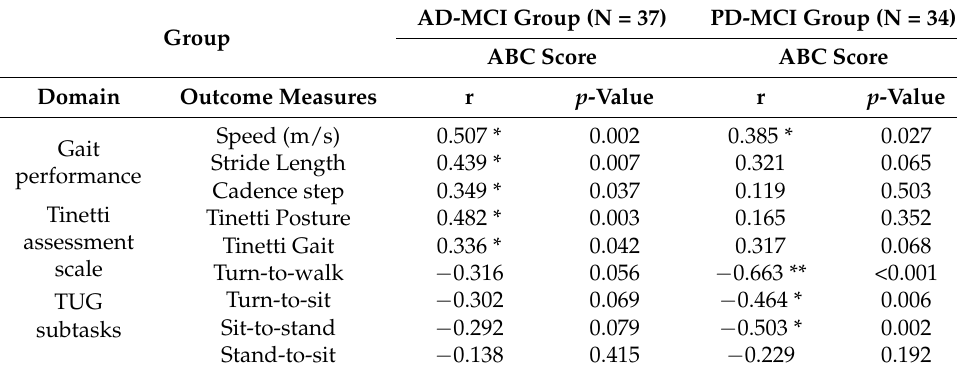
Table 3. Correlation coefficients between gait performance and ABC scores.